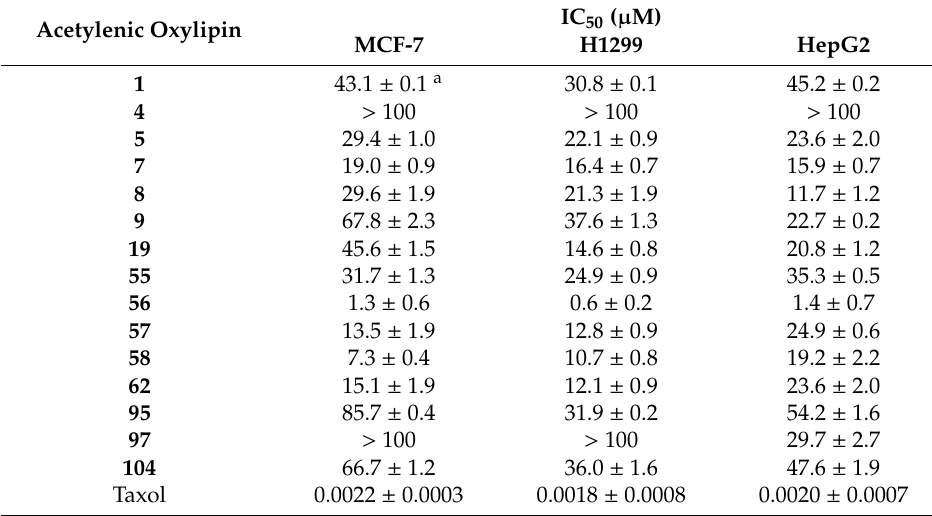
Table 2. Cytotoxic e ff ects of acetylenic oxylipins ( 1 , 4 , 5 , 7 – 9 , 19 , 55 , 57 , 58 , 62 , 95 , 97 , 104 ) isolated from Notopterygium incisum as well as the synthetic (3 S )-isomer of notopolyenol A ( 56 ) and the positive control taxol against the cancer cell lines MCF-7, H1299 and HepG2 [168]. Acetylenic